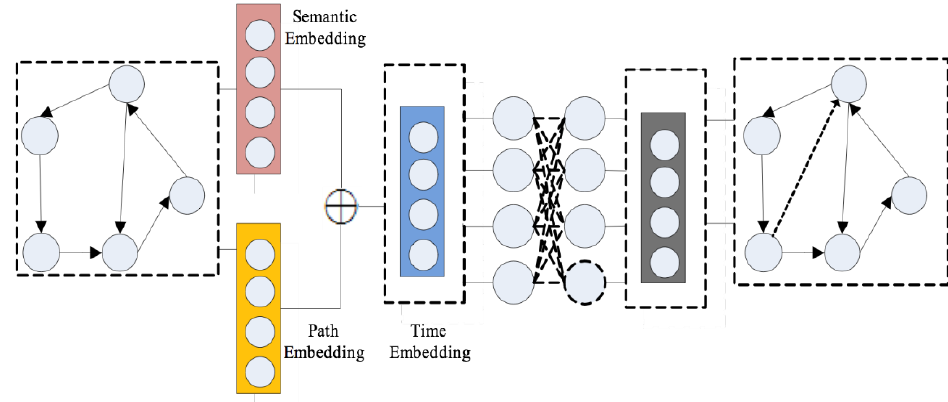
Figure 1. Knowledge conflict resolution model in a knowledge graph.